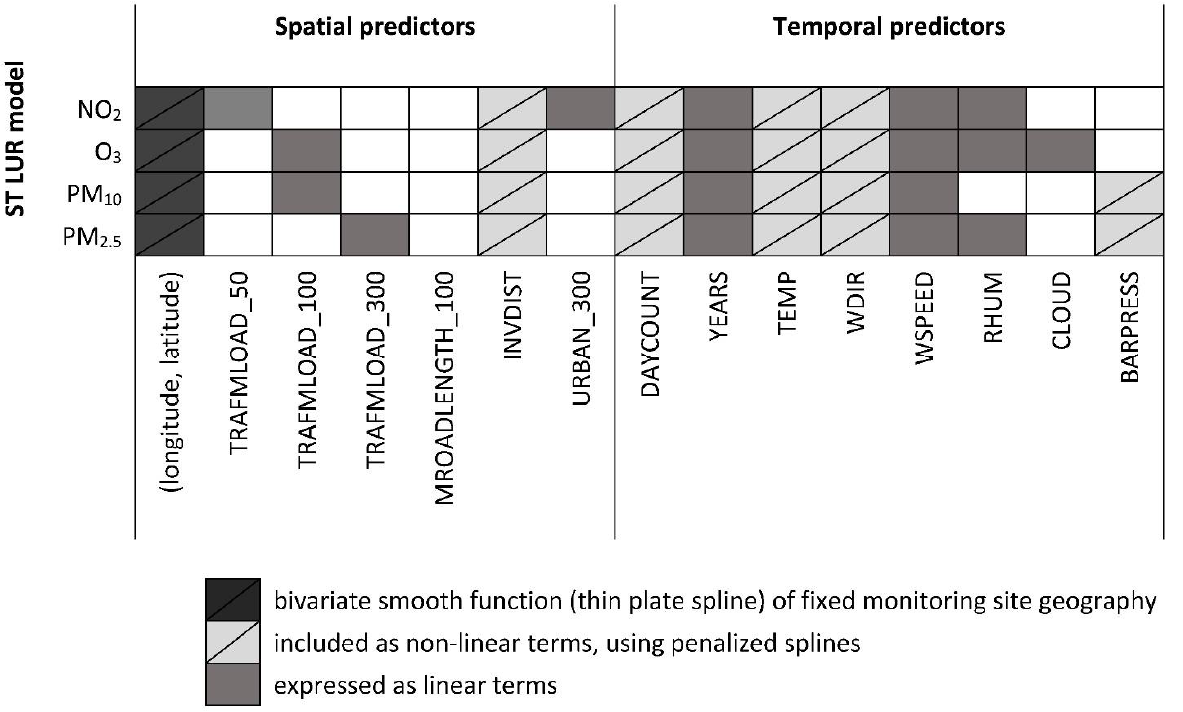
Figure 2. Predictor variables included in the final spatio-temporal land use regression (ST LUR) models developed for NO 2 , O 3 , PM10 and PM2.5 ( µ g/m 3 ), in the Greater London Area for the years 2009 to 2013. TRAFMLOAD_50; TRAFMLOAD_100; TRAFMLOAD_300: traffic load of major roads (veh*m/day) in a buffer of 50m, 100m and 300m around each fixed monitoring site, respectively; MROADLENGTH_100: total length of major roads (m) in a buffer of 100m around each fixed mon- itoring site; INVDIST: inverse distance of fixed monitoring sites to the nearest major road (m − 1 ); URBAN_300: urban areas (m 2 ) in a buffer of 300m around each fixed monitoring site; DAYCOUNT: day count variable accounting for trends within each year coded from 1 to 365 or 366 (included penal- ized splines with 6 degrees of freedom (df)); YEARS: years of the study period (4 dummy variables with year 2009 as reference category); TEMP: daily mean temperature ( ◦ C, included penalized splines with 3 df); WDIR: daily mean wind direction ( ◦ N, included penalized splines with 3 df); WSPEED: daily mean wind speed (m/s); RHUM: daily mean relative humidity (%); CLOUD: daily mean cloud coverage (okta); BARPRESS: daily mean barometric pressure (mBar/hPa, included penalized splines with 3